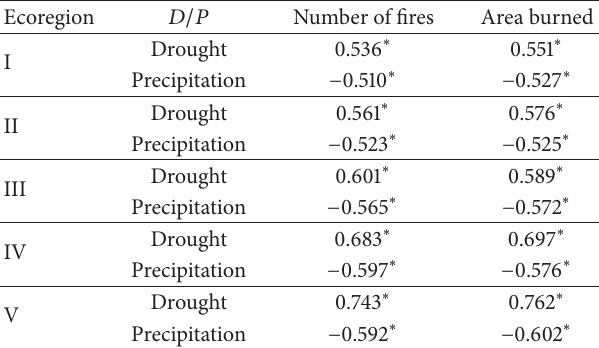
Table 4: Spearman’s correlation coefficient between precipitation amounts, drought index values, and fire activity in fire season for five ecoregions in Yunnan province, during the period